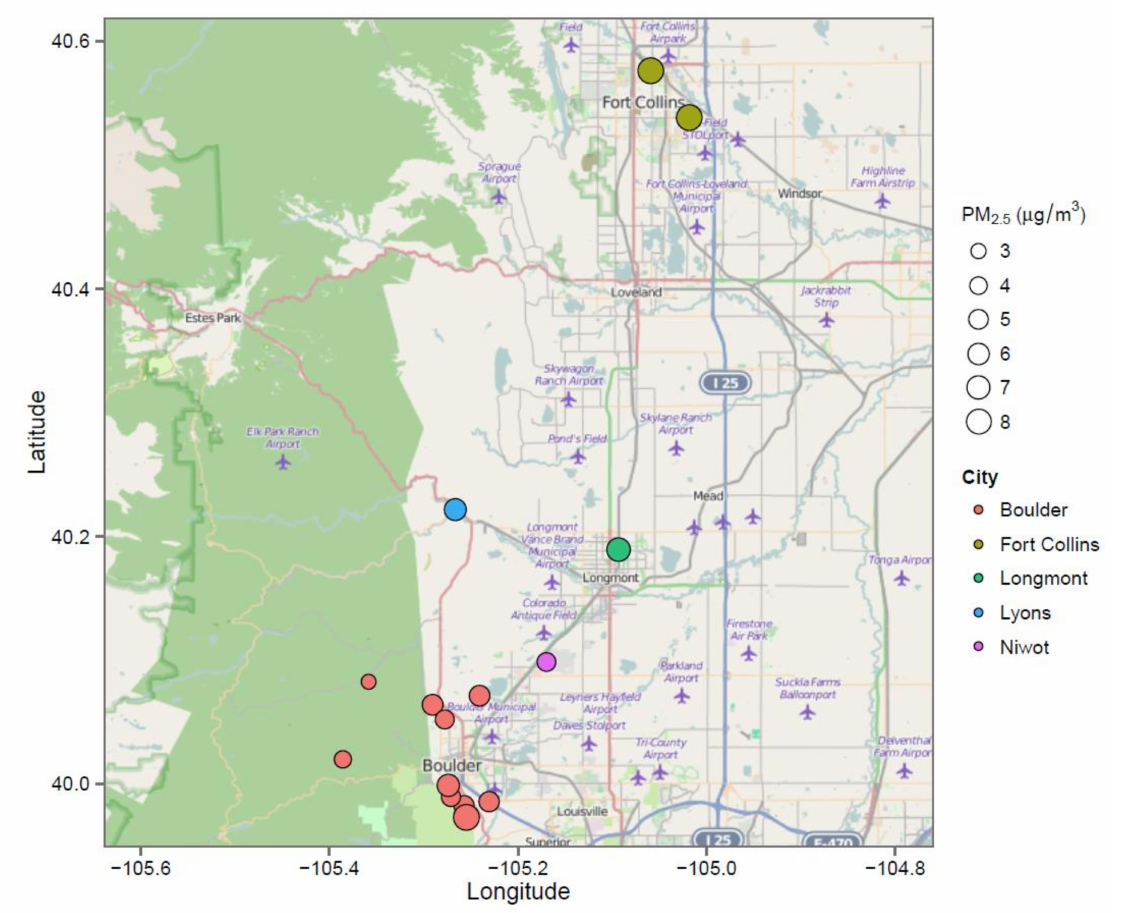
Figure 1. Study homes in the Front Range of Colorado (marker size represents median outdoor particulate matter (PM) 2.5 in µ g/m 3 measured at each home, ©OpenStreetMap